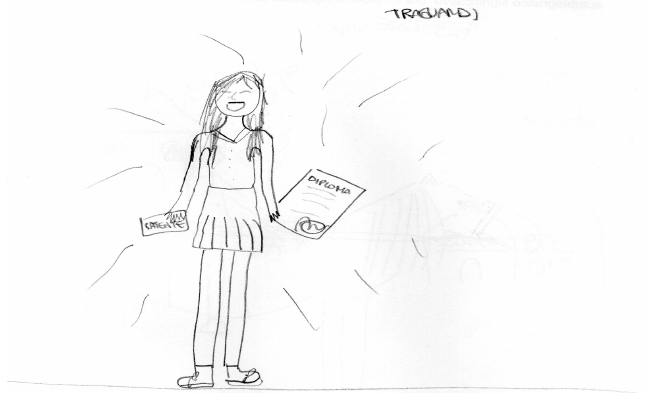
Figure 5. Drawing, referring to adolescence, entitled